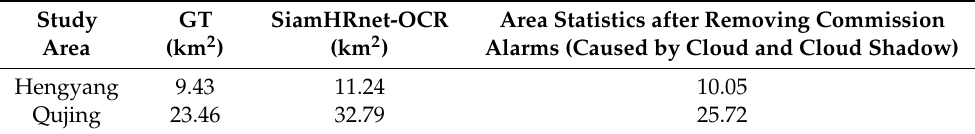
Table 7. Area of deforestation in Hengyang City and Qujing